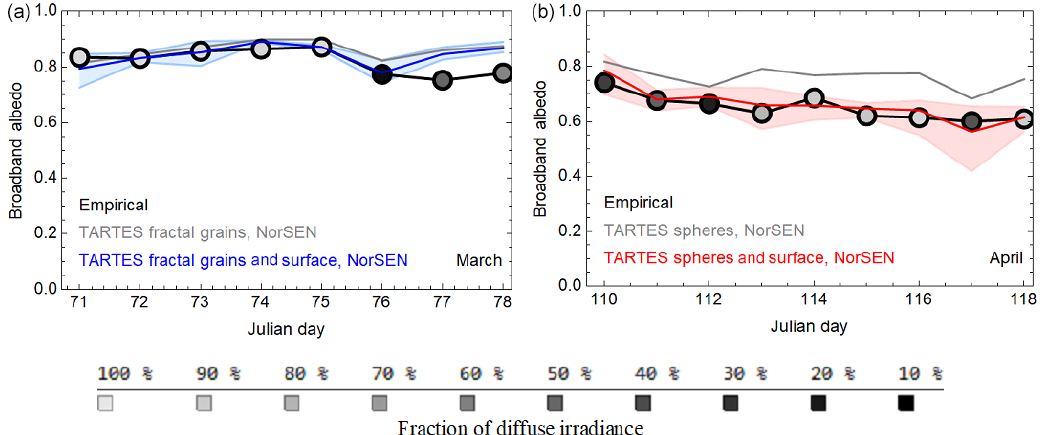
Figure 12. Simulated albedo values at the NorSEN mast based on density, grain size and surface roughness measurements of snow in 12–19 March 2009 and in 20–28 April 2009 and temporally interpolated impurity content data. The mean values are shown separately for the TARTES model containing only the volume scattering contribution (grey curve) and the TARTES model combined with the surface scattering model of this study (blue or red). The daily variation range based on diverse profiles, grain size and density measured at the site and temporally interpolated impurity content are shown as the area shaded by light blue or light red colour. The darkness of the empirical points indicates the fraction of diffuse irradiance during the